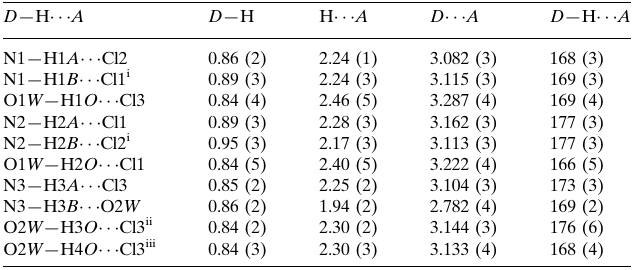
Hydrogen-bond geometry (A˚ , (cid:3) ). D —H (cid:1)(cid:1)(cid:1)